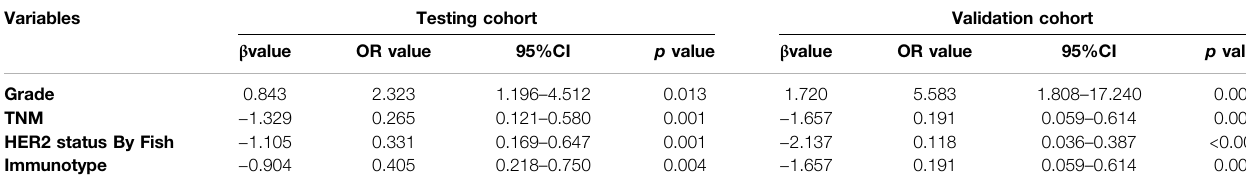
TABLE 3 | Multivariate logistic regression